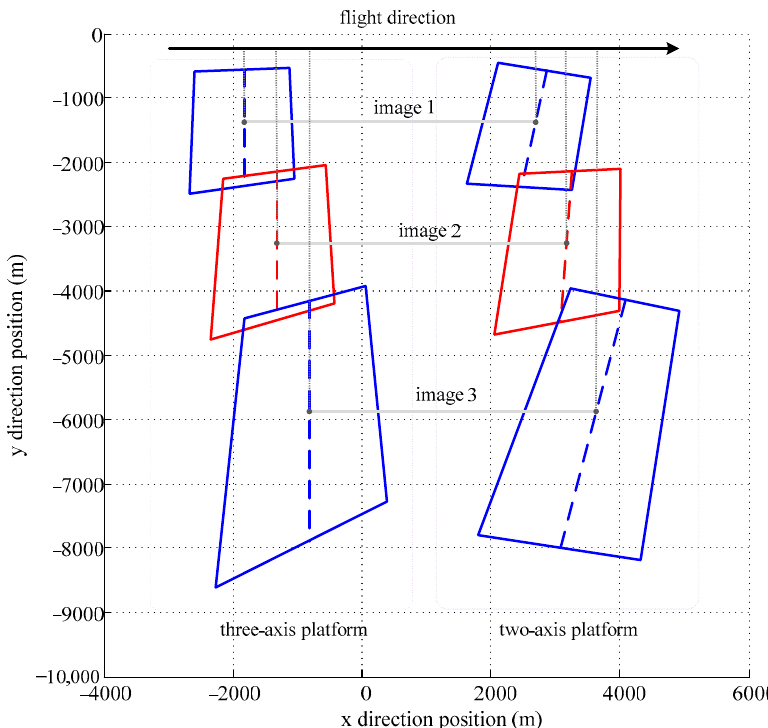
Figure 4. Image projection maps on the ground plane for the three-axis and two-axis platforms. Table 1. Three-axis and two-axis platform gimbal angles.